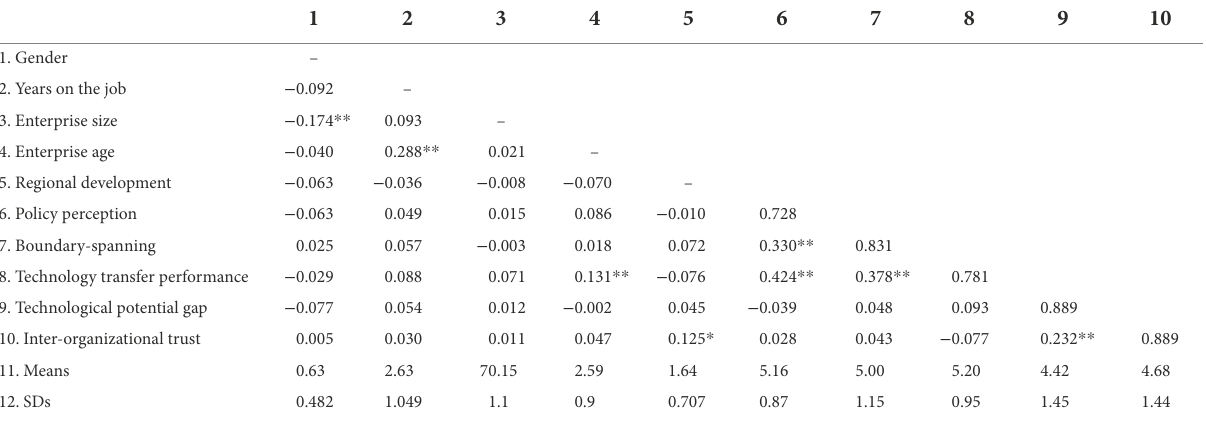
TABLE 4 Mean, standard deviation, correlation coefficient and AVE value of each main variable.